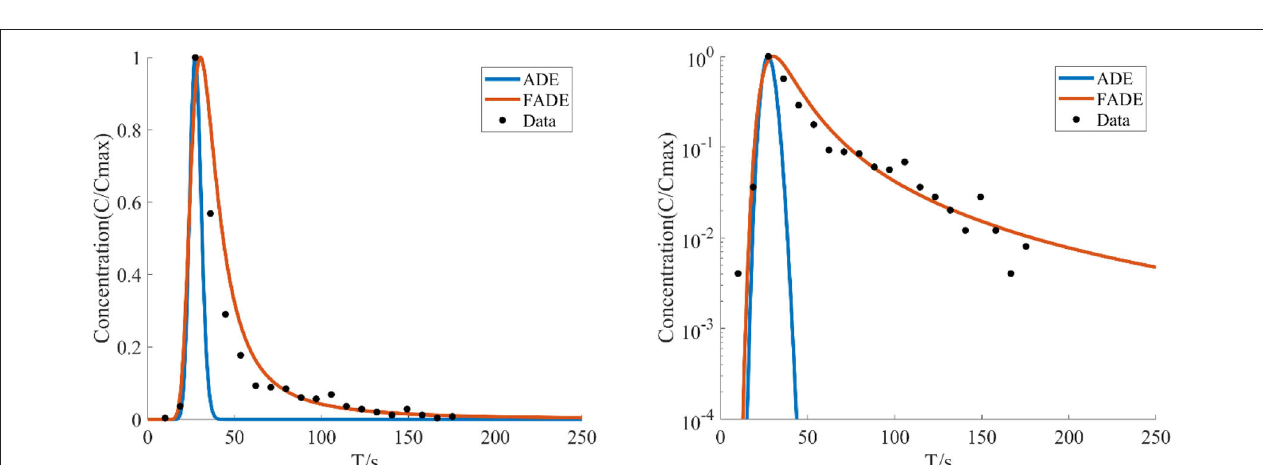
Frontiers in Physics |